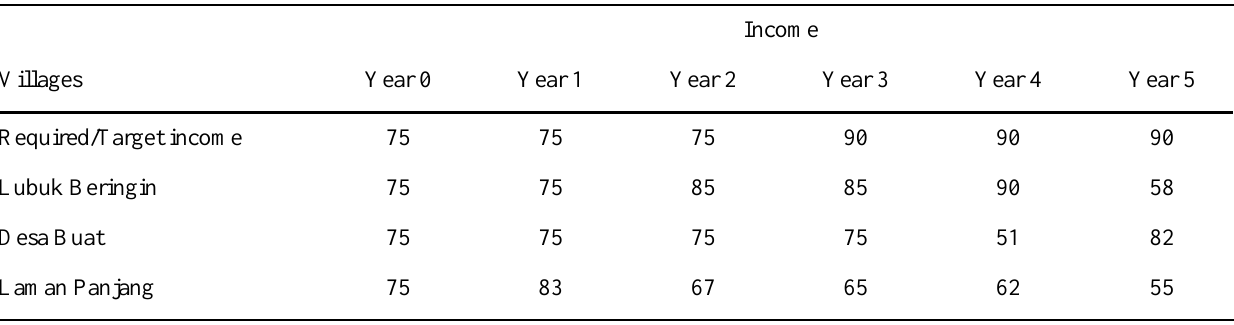
Table 7. Summary of the score sheets representing the yearly income of the villages vs. the target income to support the village population